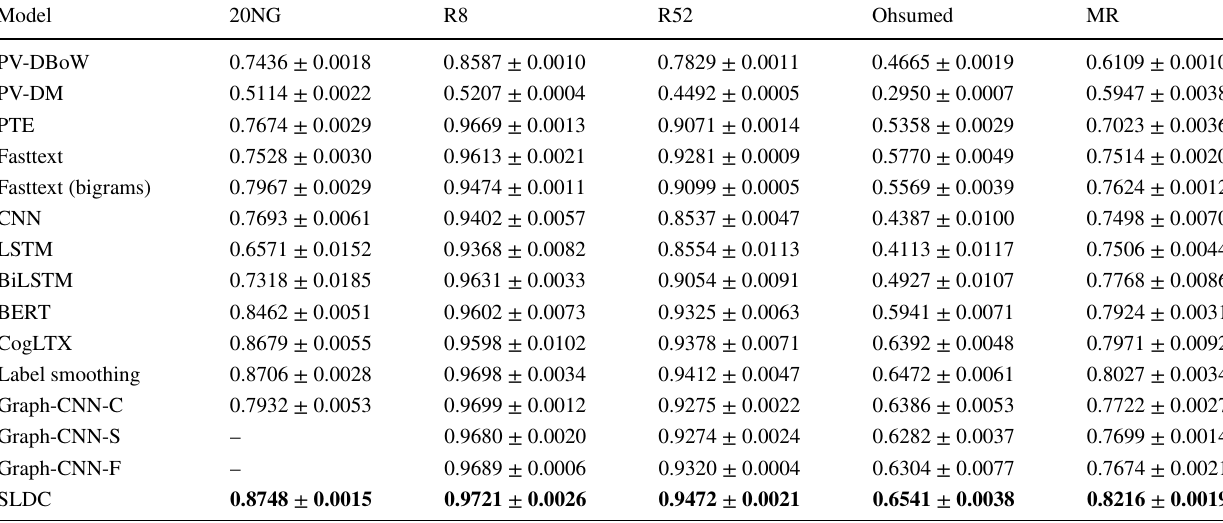
Table 2 Accuracy of compared models on different datasets. The best results have been bolded